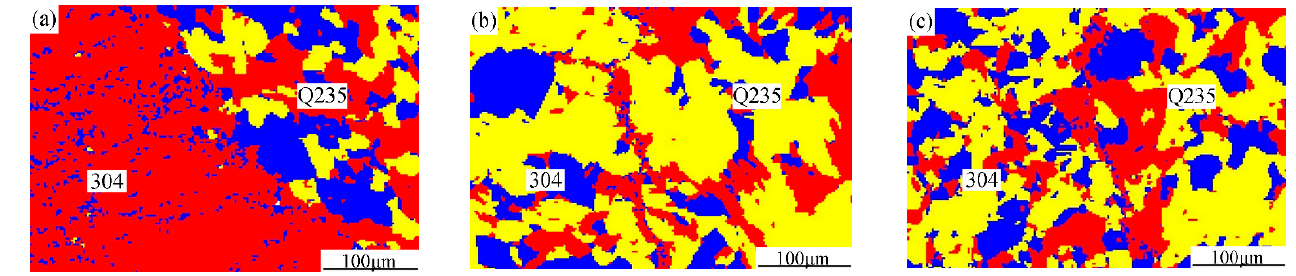
Figure 5. The distribution of dynamic recrystallized grains at ( a ) 950 °C, 0.1 s − 1 , ( b ) 1100 °C, 0.1 s − 1 and ( c ) 1100 °C, 1 s − 1 .